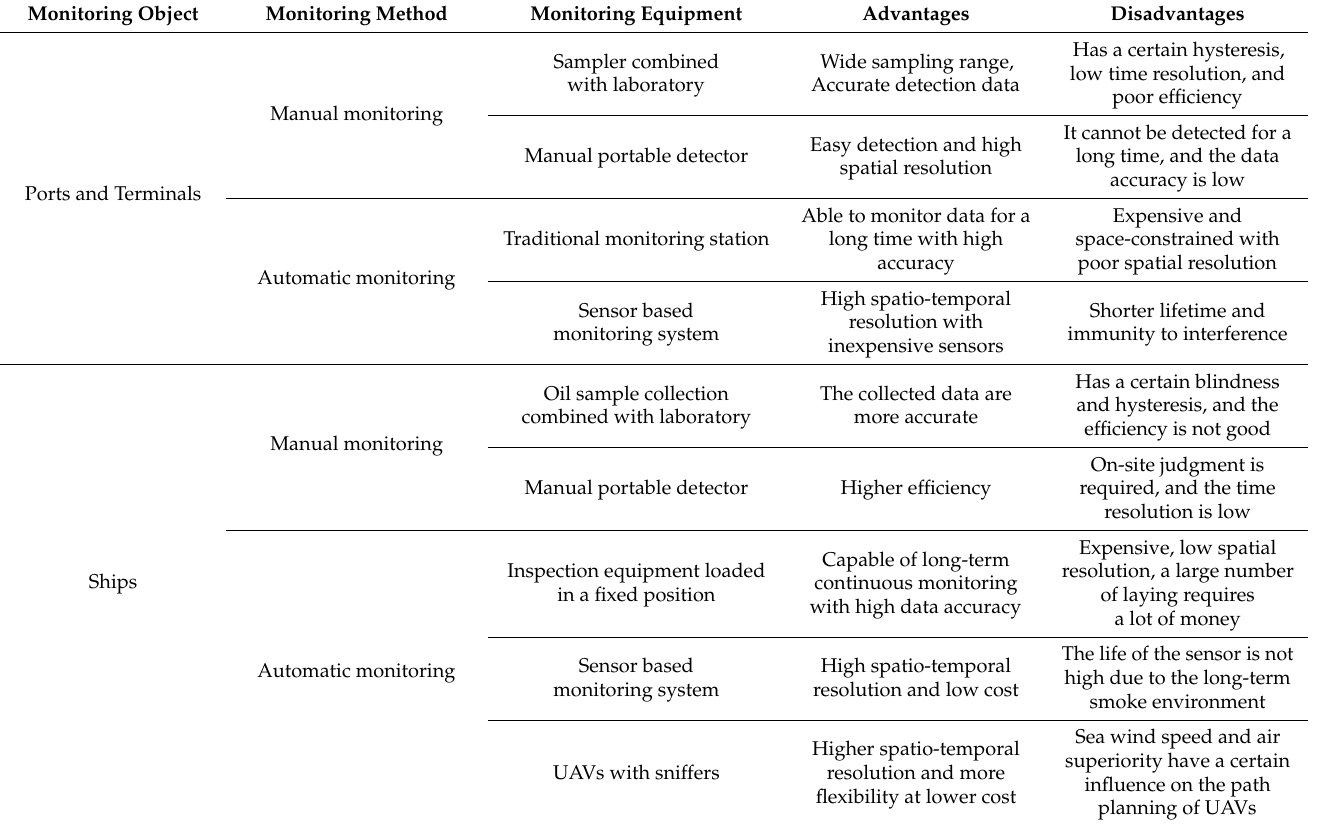
Table 6. Commonly used monitoring methods for ports and